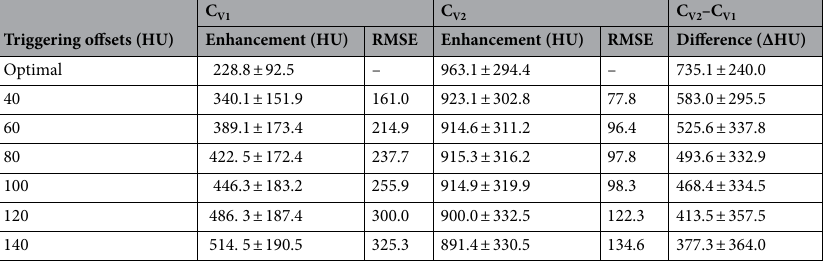
Table 3. Simulated prospective enhancement versus optimal enhancement in the pulmonary artery. The “Optimal Enhancement” in the pulmonary artery is the simulated result from the gamma variate fitting curve. Specifically, C V1 was calculated as the average enhancement within the PA region at the time of the second derivative peak, C V2 was the average enhancement within the PA region at the time of peak enhancement. The root-mean-square-error (RMSE) between each triggering protocol and the ideal enhancement was also calculated. The change in contrast enhancements ( ∆HU ) between C V1 and C V2 is shown in the last column. P values in all comparisons are less than 0.001. Blood flow is measured based on ∆HU. Therefore, it is best for C V1 to be as low as possible and C V2 to be as high as possible.